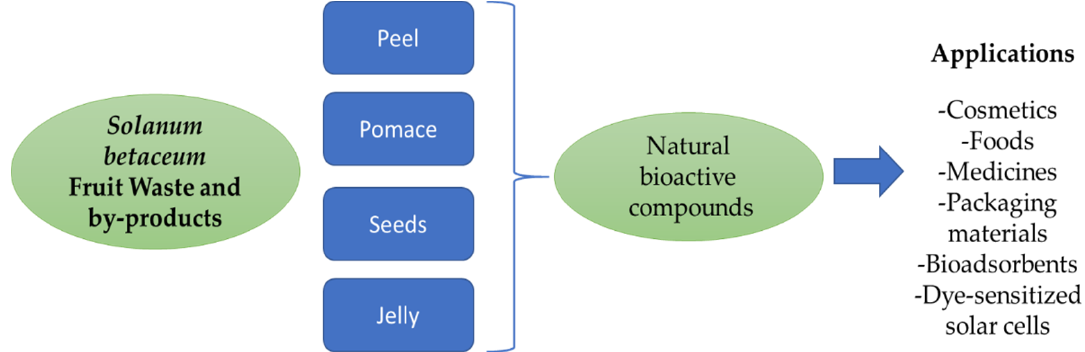
Figure 4. Applications of Solanum betaceum fruits waste.